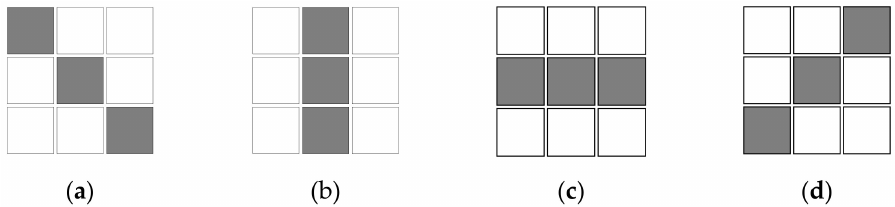
Figure 2. Schematic diagram of four-direction structural elements. ( a ) the unit matrix; ( b ) the matrix with 0 except the second column as 1; ( c ) the matrix with 0 except the second row as 1; ( d ) the sub-diagonal matrix as 1 and the rest as